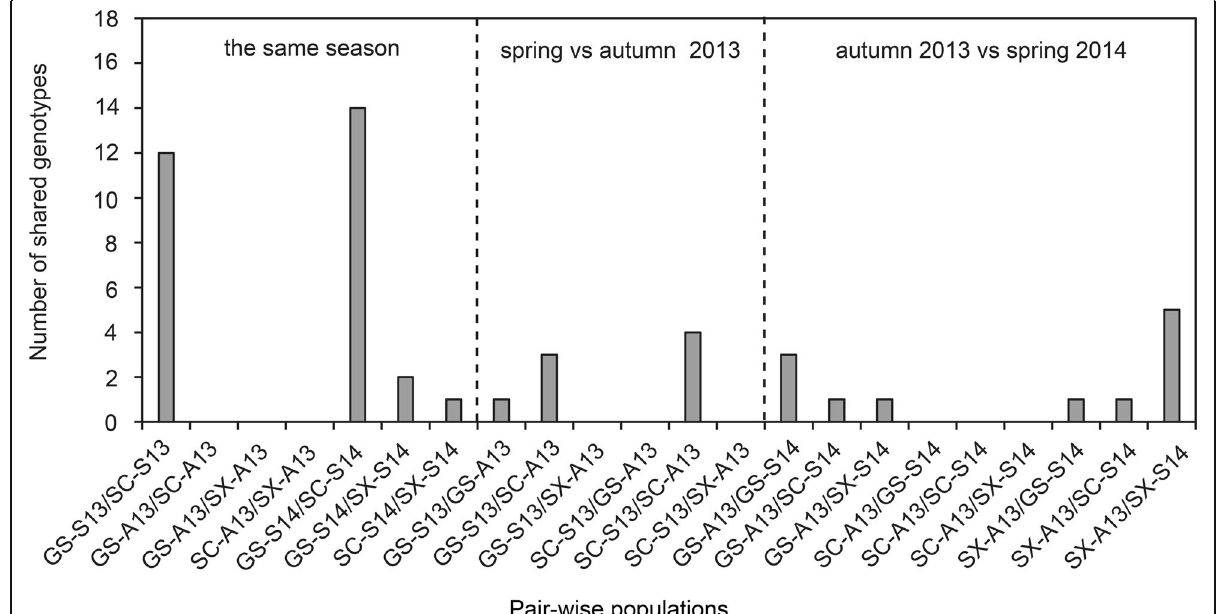
Fig. 2 Number of shared genotypes between paired seasonal subpopulations from Gansu, Sichuan, and Shaanxi Provinces. S13 = Spring of 2013, A13 = autumn of 2013, and S14 = spring of 2014. Gansu = GS, Sichuan = SC, Shaanxi =